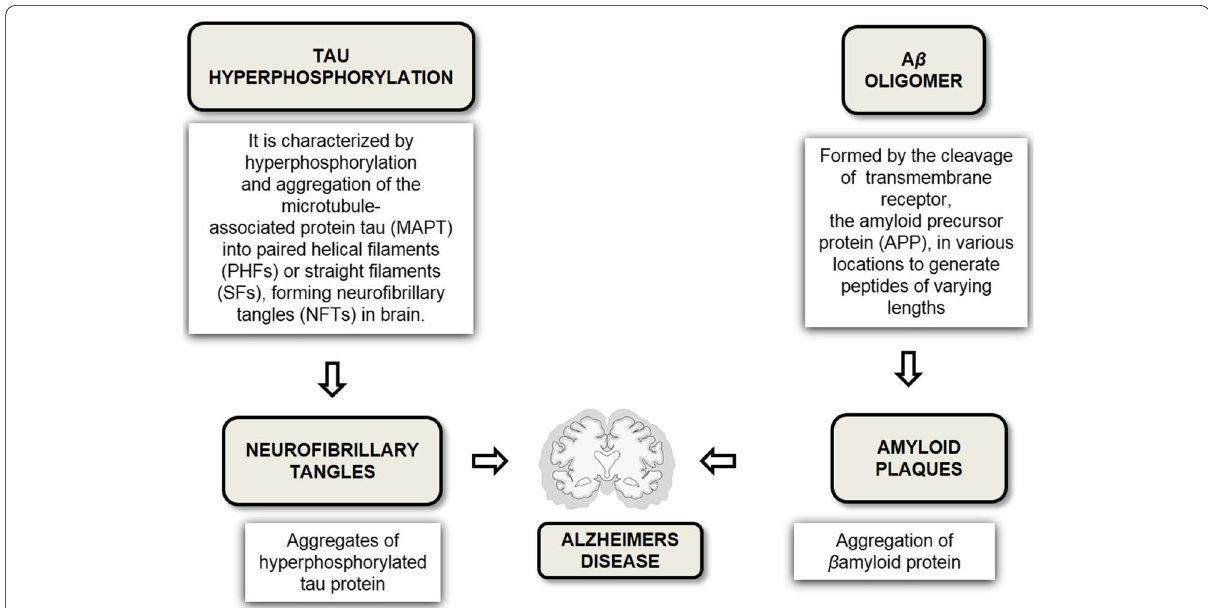
Fig. 3 Pathological hallmarks of Alzheimer’s